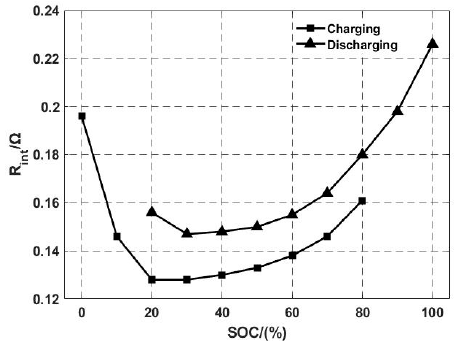
Figure 7. Resistance as a function of battery SOC.